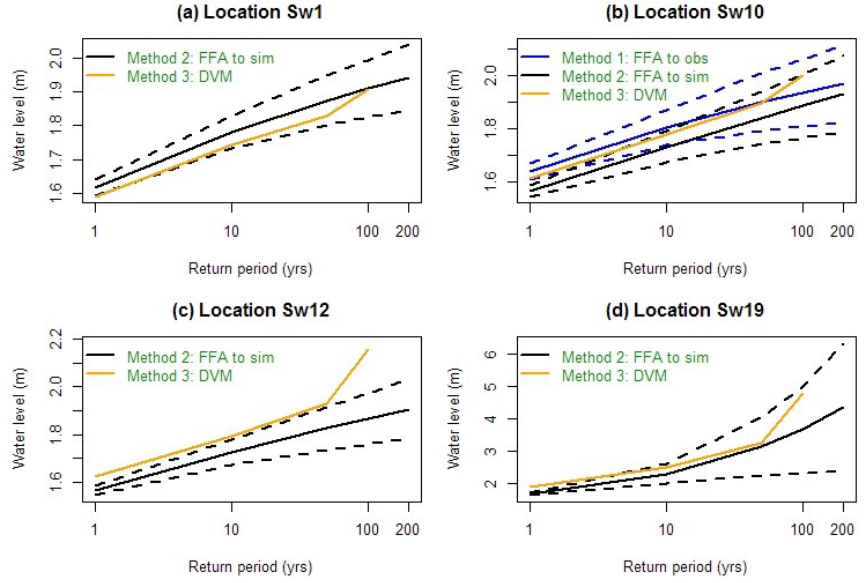
Figure 10. Comparison between the three different methods for flood estimation. The solid lines represent estimates using each method. The dotted lines represent the 95% confidence interval where